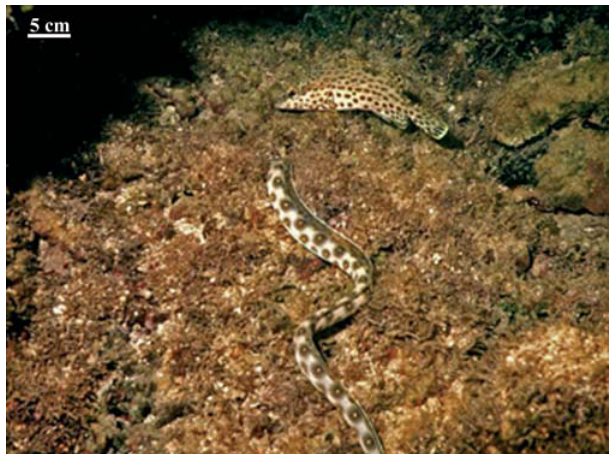
Fig. 3. Interspecific foraging association between Myrichthys ocellatus and Epinephelus adscensionis . The head of the follower fish is close to the Goldspotted eel, which is in a hole seeking for prey. Photo by M. E.